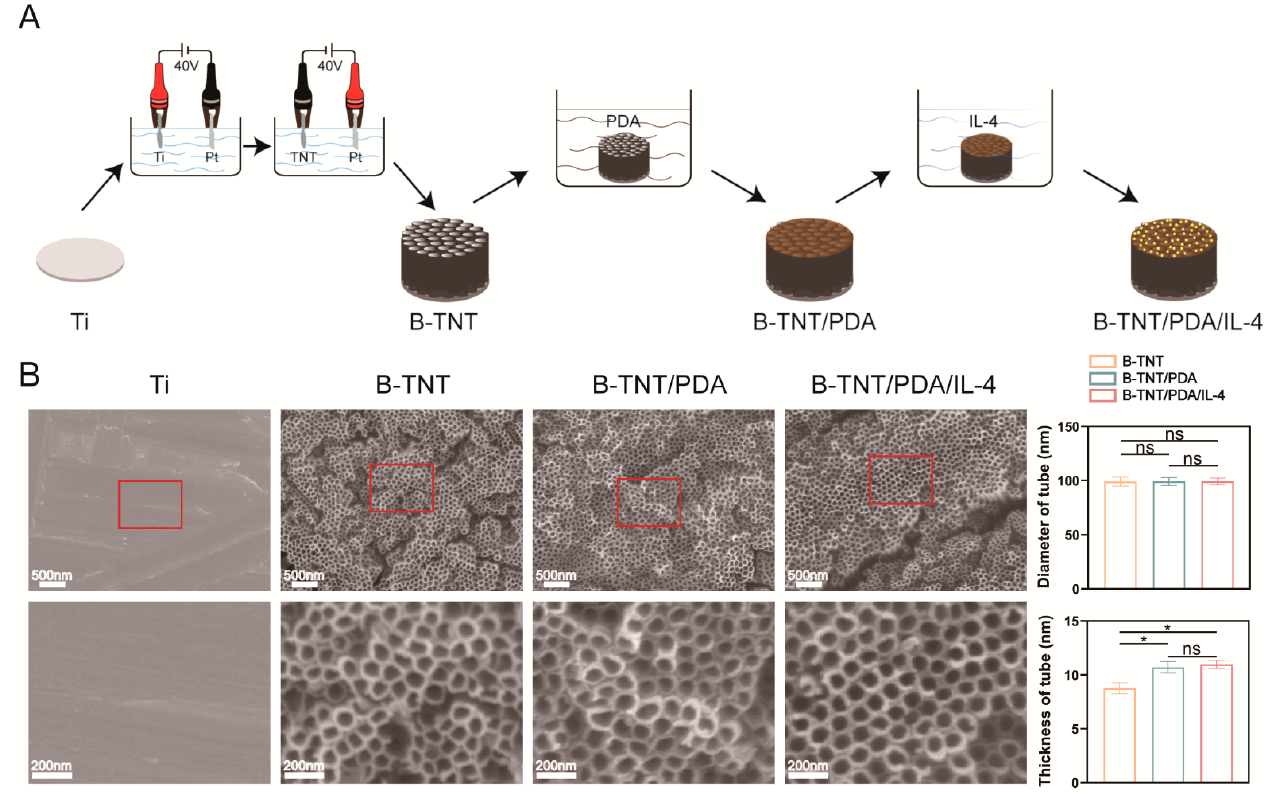
Figure 3. ( A ) Schematic illustration of the fabrication of different surfaces. ( B ) Representative scanning electron microscope (SEM) images and quantitative analyses of B-TNT, B-TNT/PDA and B-TNT/PDA/IL-4 surfaces. * indicates statistical difference between groups ( p < 0.05); ns means no statistical difference between groups.